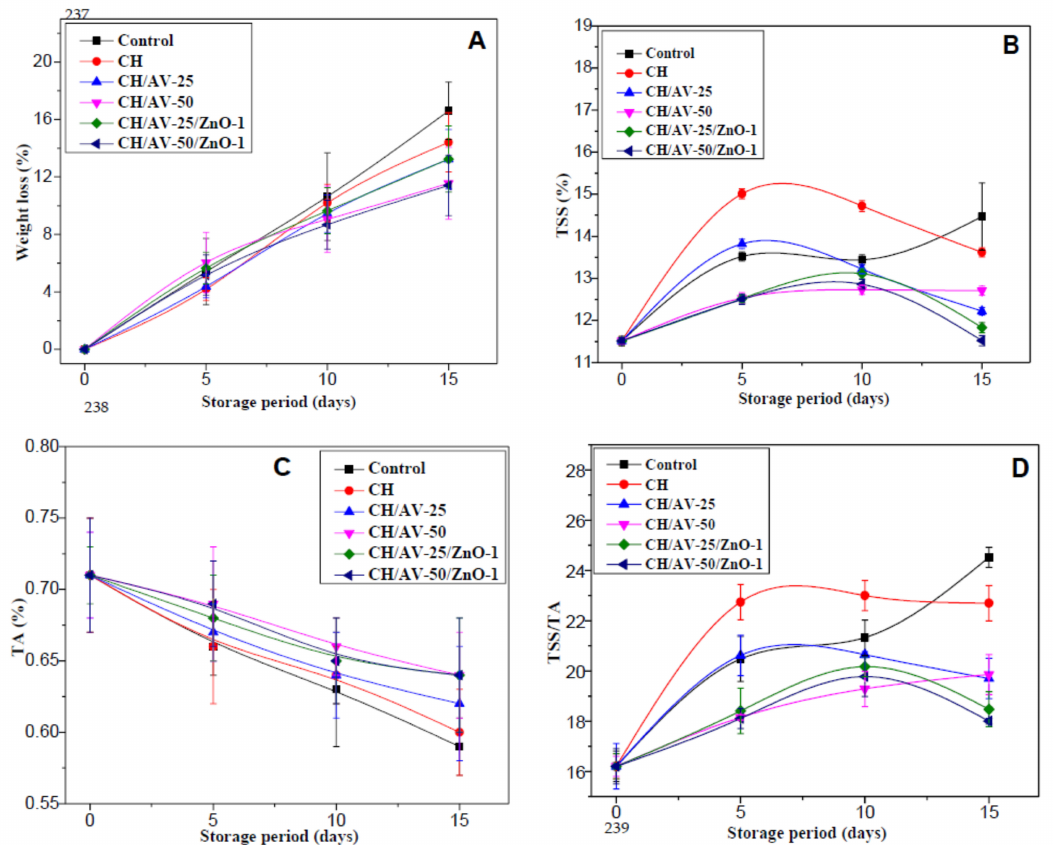
Figure 2. Effects of coating formulations on ( A ) weight loss, ( B ) TSS contents, ( C ) TA, and ( D ) maturity index (TSS/TA) of the treated and untreated pineapple fruit stored at ambient condition for 15